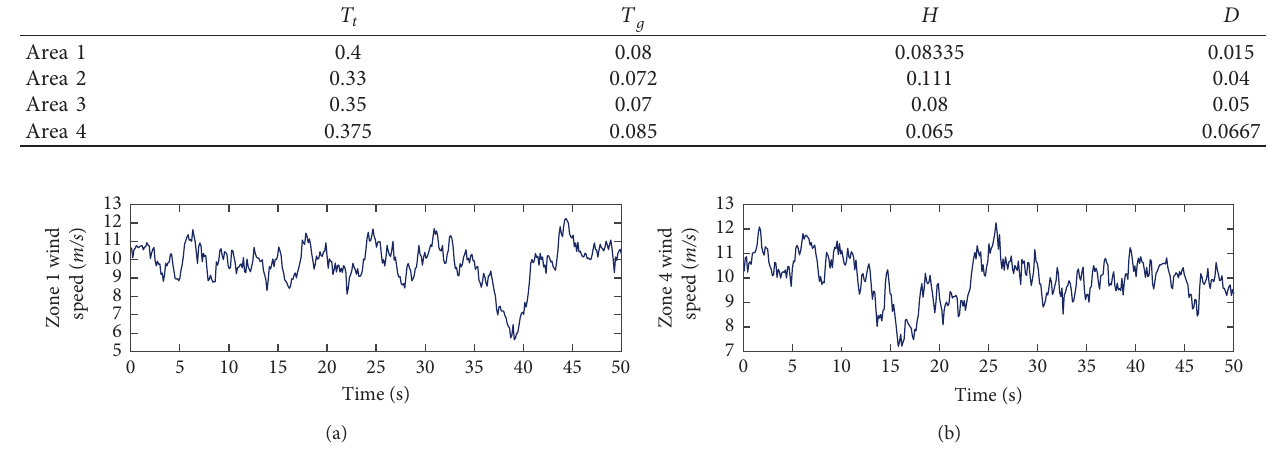
Figure 8: Wind speed series curve. (a) 50 s wind speed sequence input in zone 1. (b) 50 s wind speed sequence input in zone 4.